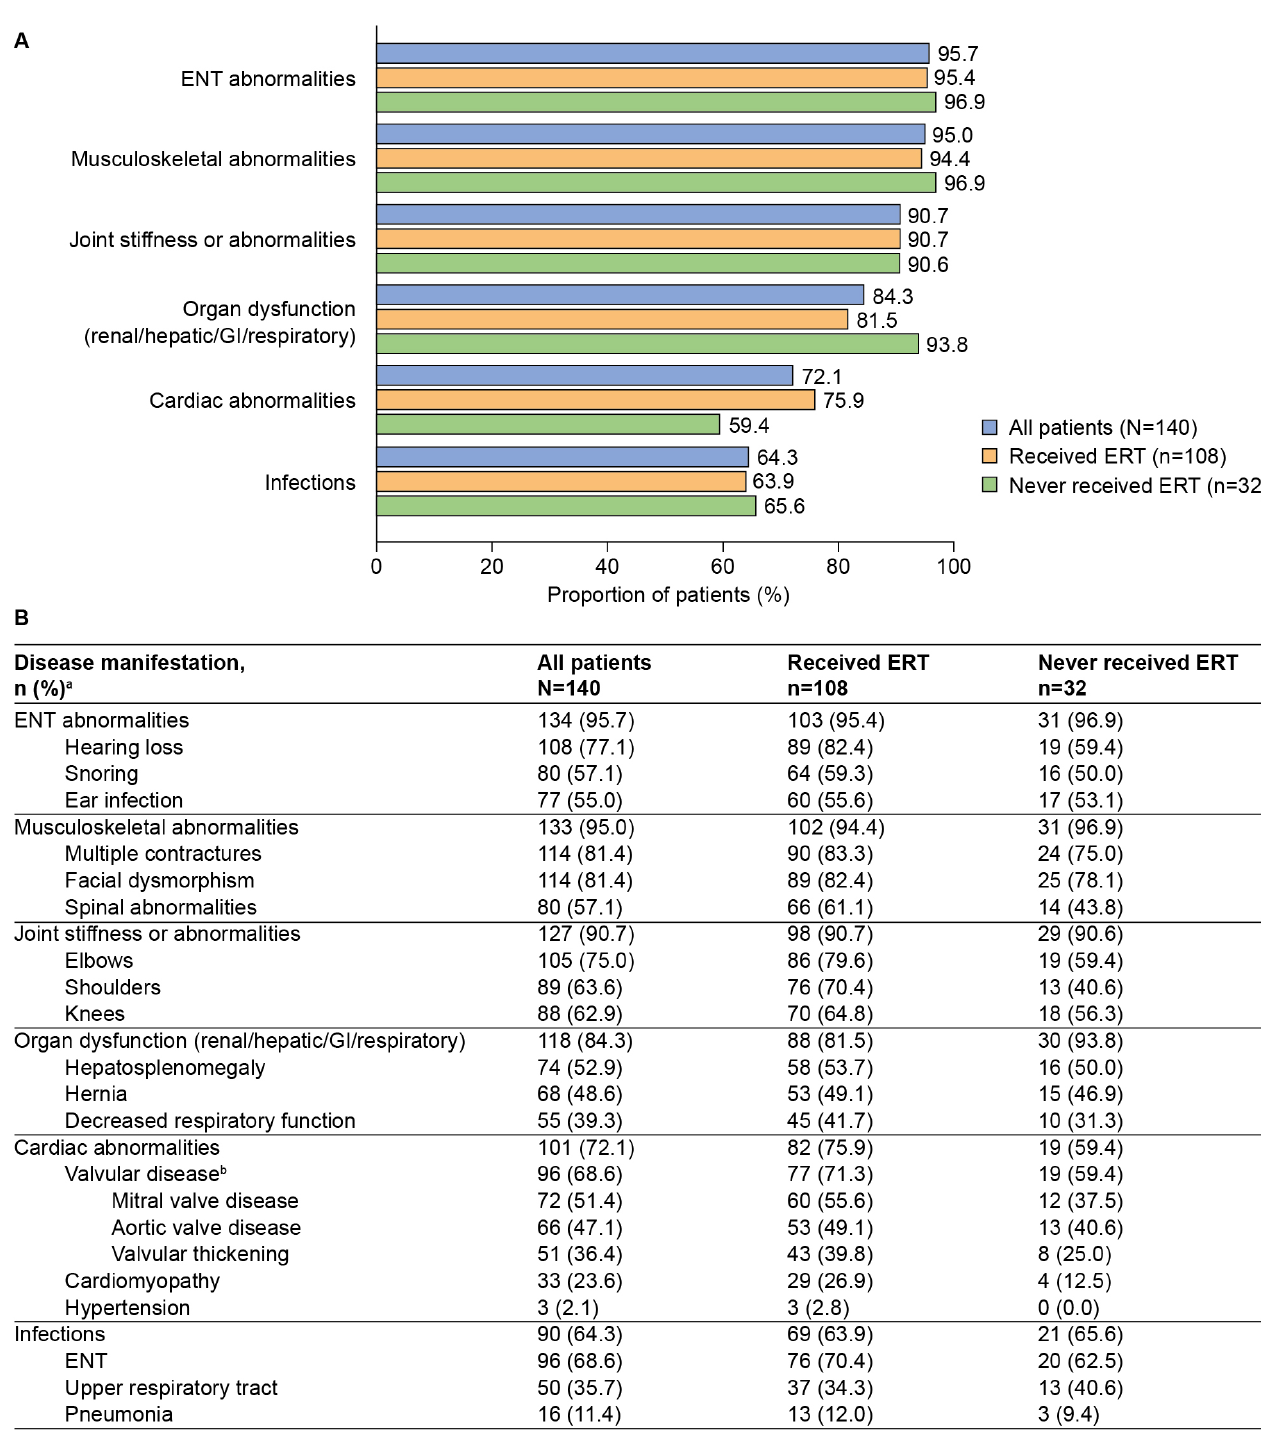
Figure 1. Prevalence of Common Disease Manifestations (>50% of